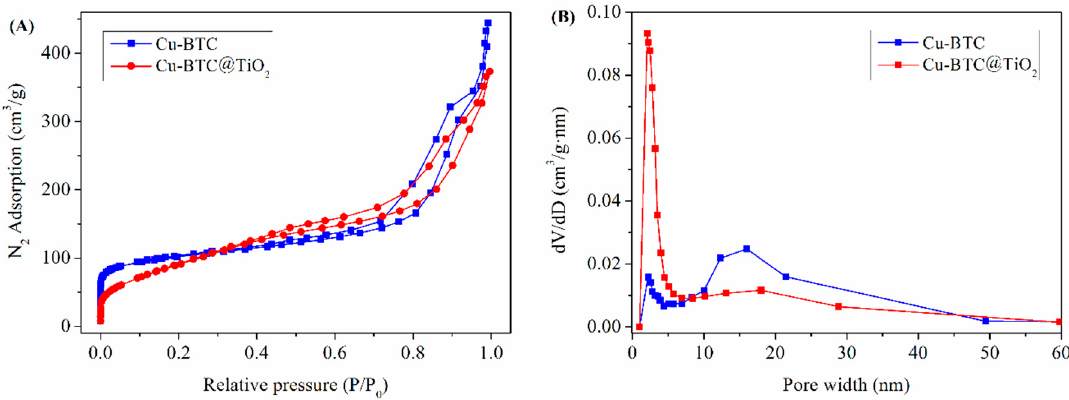
Figure 4. N 2 adsorption-desorption isotherms ( A ) and pore size distributions on the basis of the Barrett-Joyner-Halenda (BJH) method ( B ) of Cu-BTC and Cu-BTC@TiO 2 .